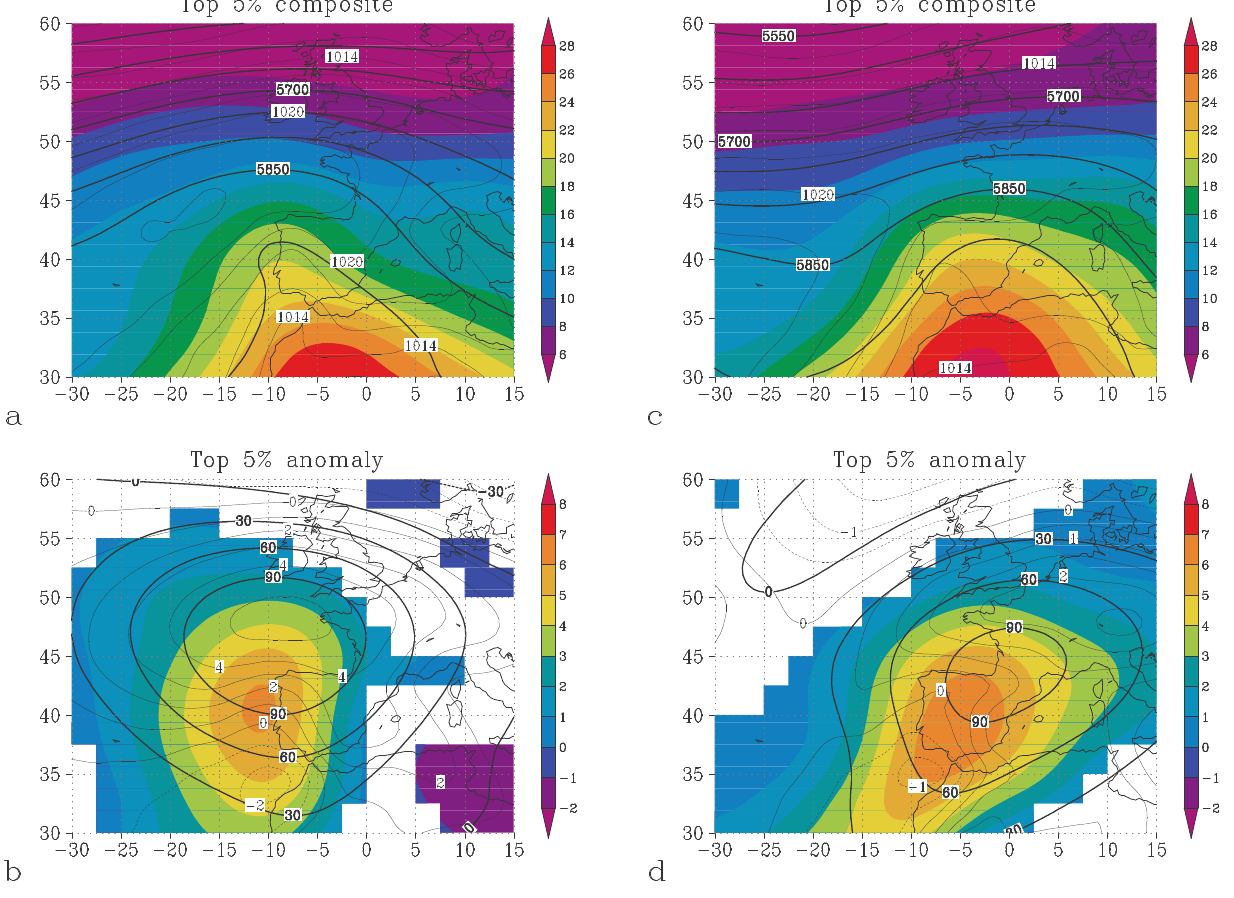
Fig. 5. Composites of 850hPa temperature in shaded colour ( ◦ C), of SLP (mb, light curve) and 500hPa (gpm, bold curve) for the top 5% of maximum summer temperature in ( a ) Lisbon and ( c ) Madrid. All data correspond to the longer period between 1958 and 1997. The corresponding top 5% anomaly composites, after removing the summer average, are represented in ( b ) Lisbon and ( d ) Madrid. The 850hPa temperature anomaly field is represented only in those areas where such an anomaly is significant at the 5% level (or 95% confidence level) computed with a two-tailed